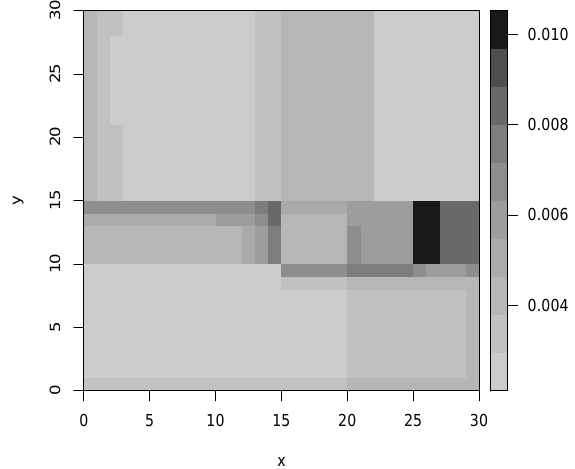
Figure 8. Map of the standard error (Example